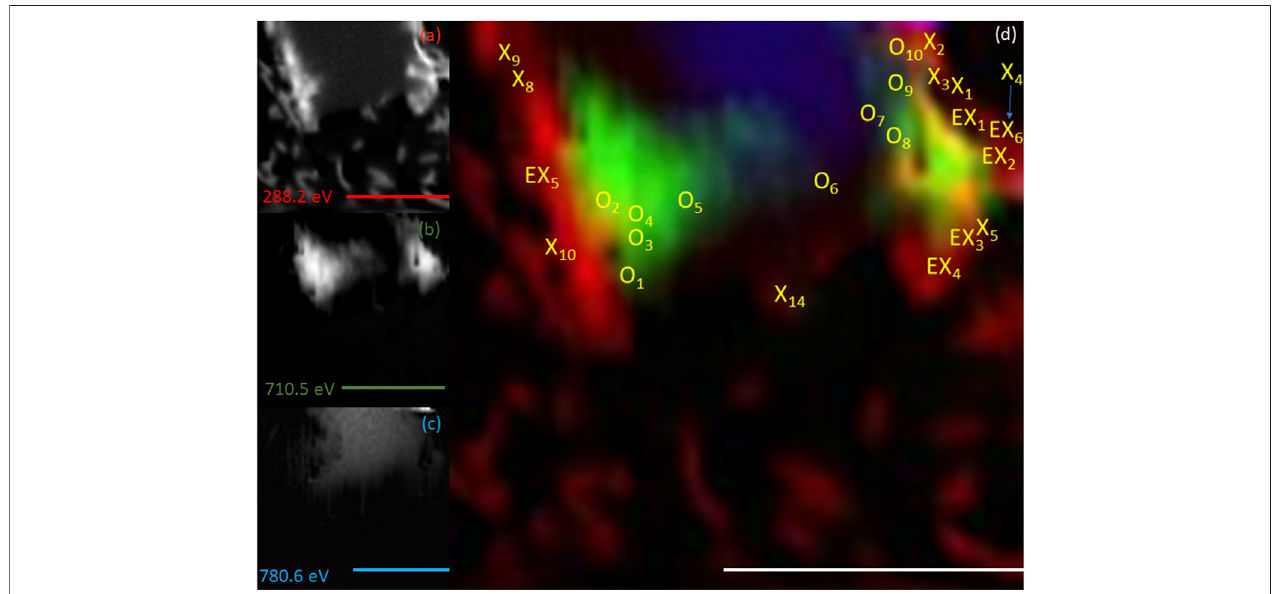
FIGURE7 | Elemental maps for the20 htimepoint for (A) C K -edge (288.2 eV;red), (B) Fe L 2,3 -edge (710.5 eV;green) and (C) Co L 2,3 -edge (780.6 eV; blue). The corresponding composite RGB (red, green, blue) image (D) shows the spatial relationship between the bacterial cells (C K -edge) and the minerals (Fe and Co L 2,3 - edges).Spectraweretakenfromregionsco-locatedwiththebacterialcells(X)andregionsnotco-locatedtothebacterialcell(O).Thecentreofthe ‘ X ’ and ‘ O ’ denotethe precise location from which the spectra were collected. All scale bars are 7 μ m.